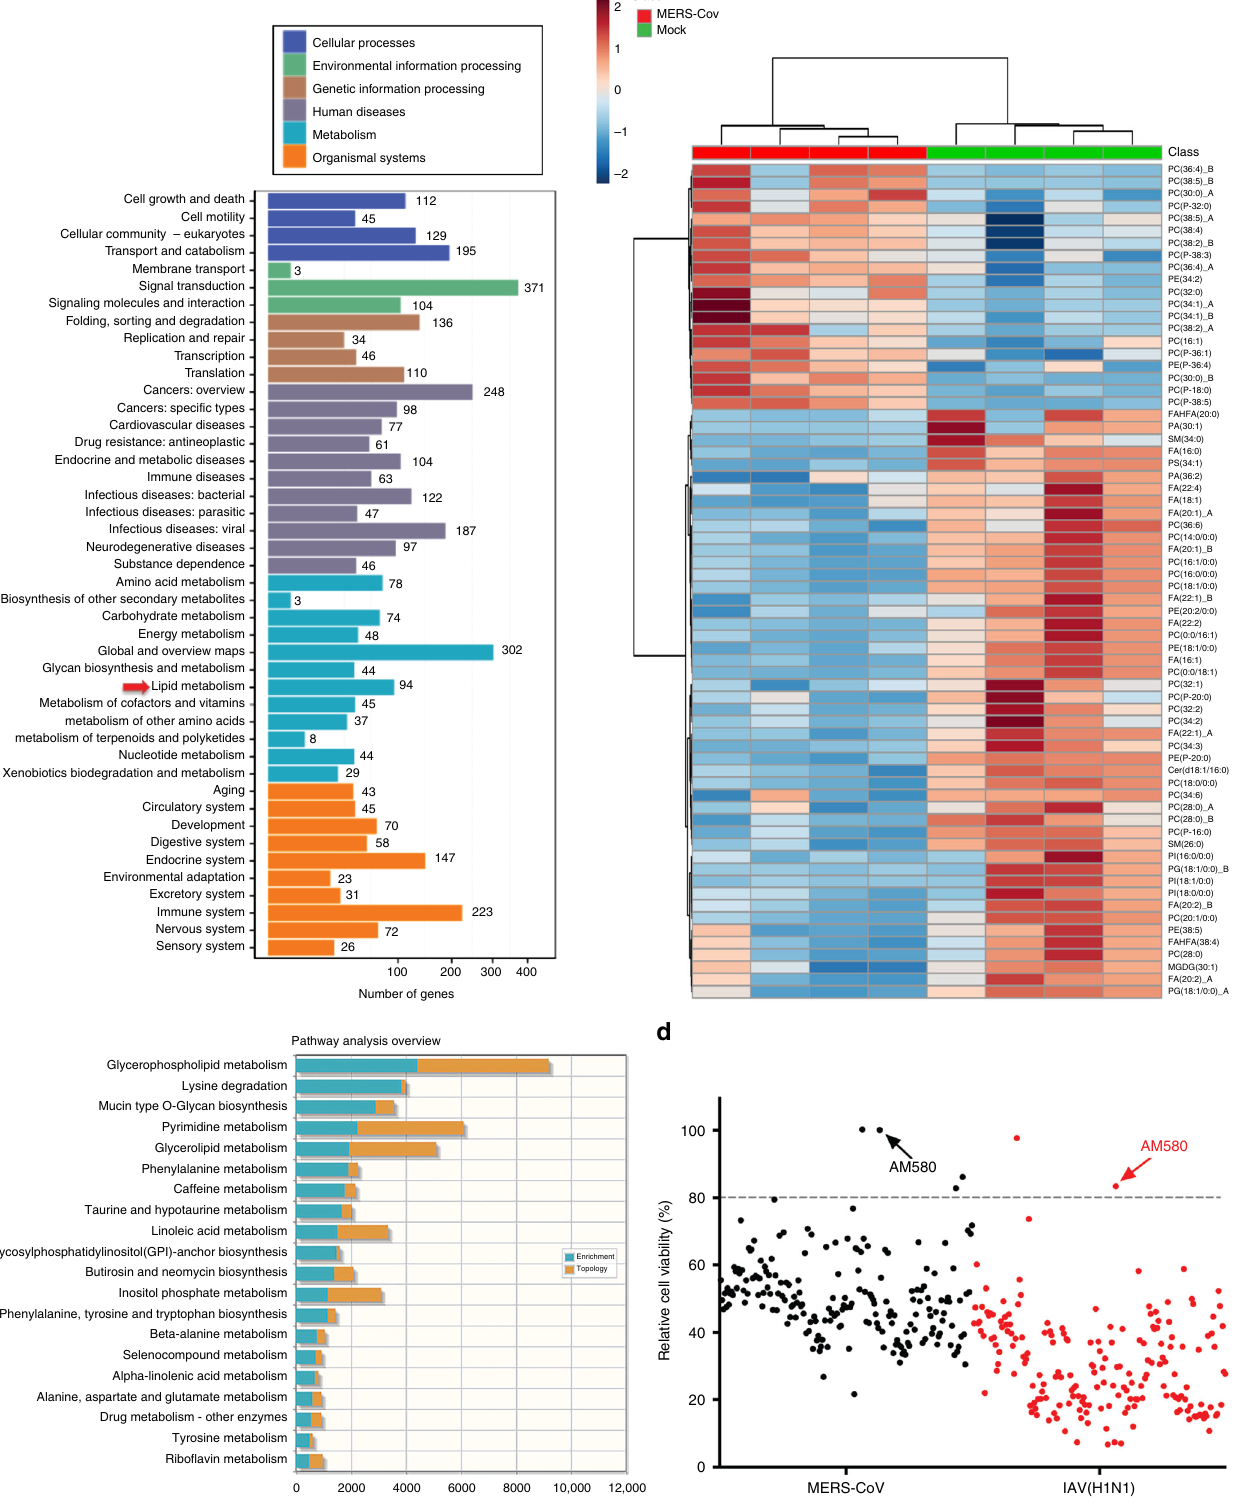
AM580 exhibited broad-spectrum antiviral effects in vitro . The cytotoxicity of AM580 was similar in different cell lines (CC 50 : 100 – 200 µM; Supplementary Figure 2a). Using MERS-CoV infection as a model, we characterized the antiviral activity of AM580 in cell cultures. First, a multi-cycle virus growth assay